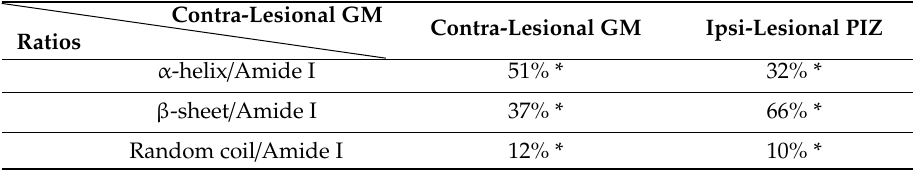
Table 3. Ratios of protein alterations in GM and